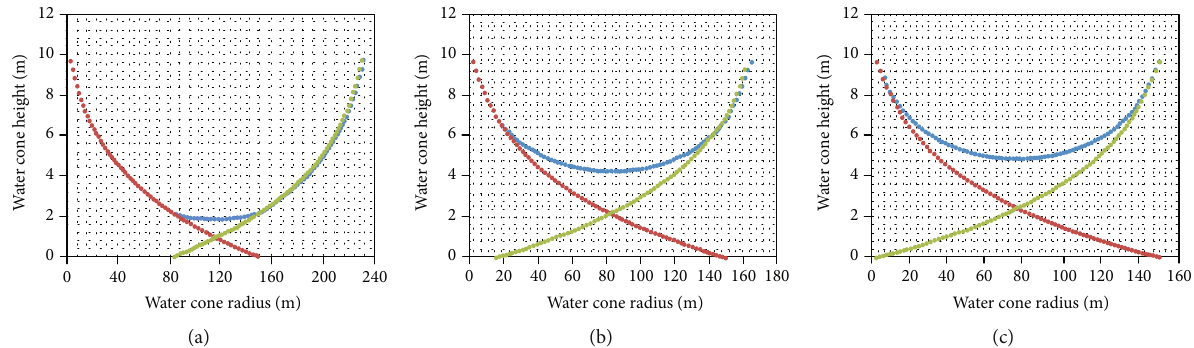
Figure 10: In fl uence of an adjacent well on the water saturation distribution in the water cone.